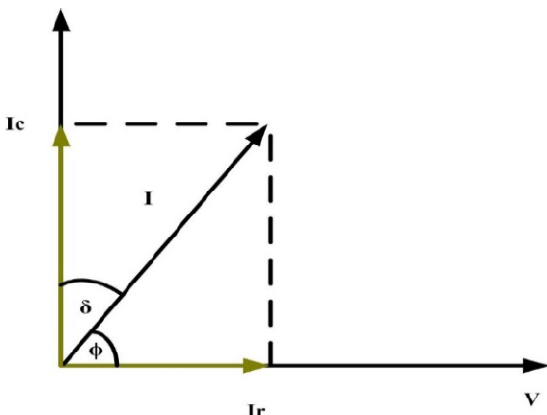
Fig. 10. Practical-dielectric (lossy)